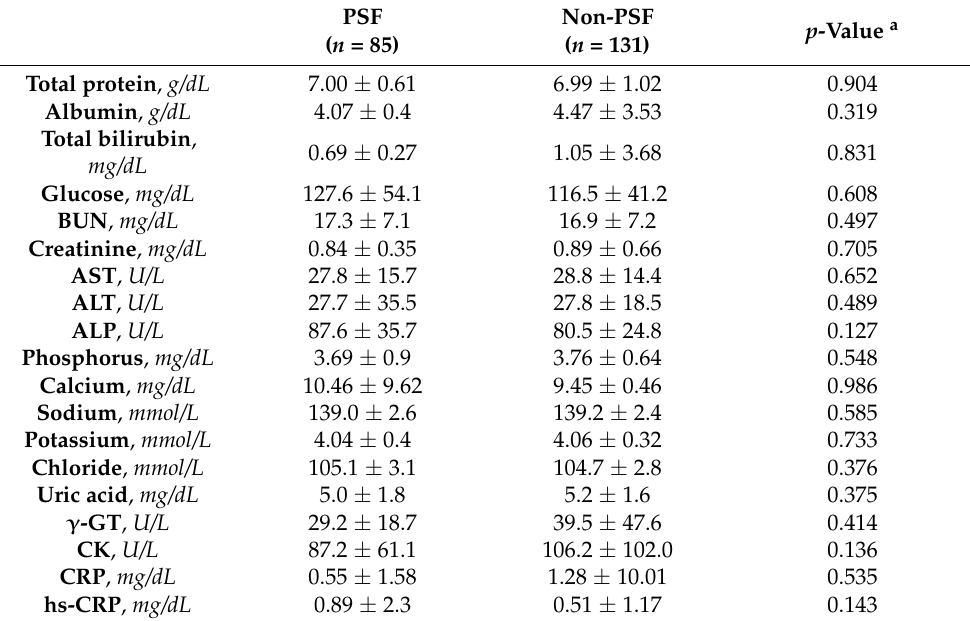
Table 4. Comparison of biochemical data between the PSF and non-PSF groups.